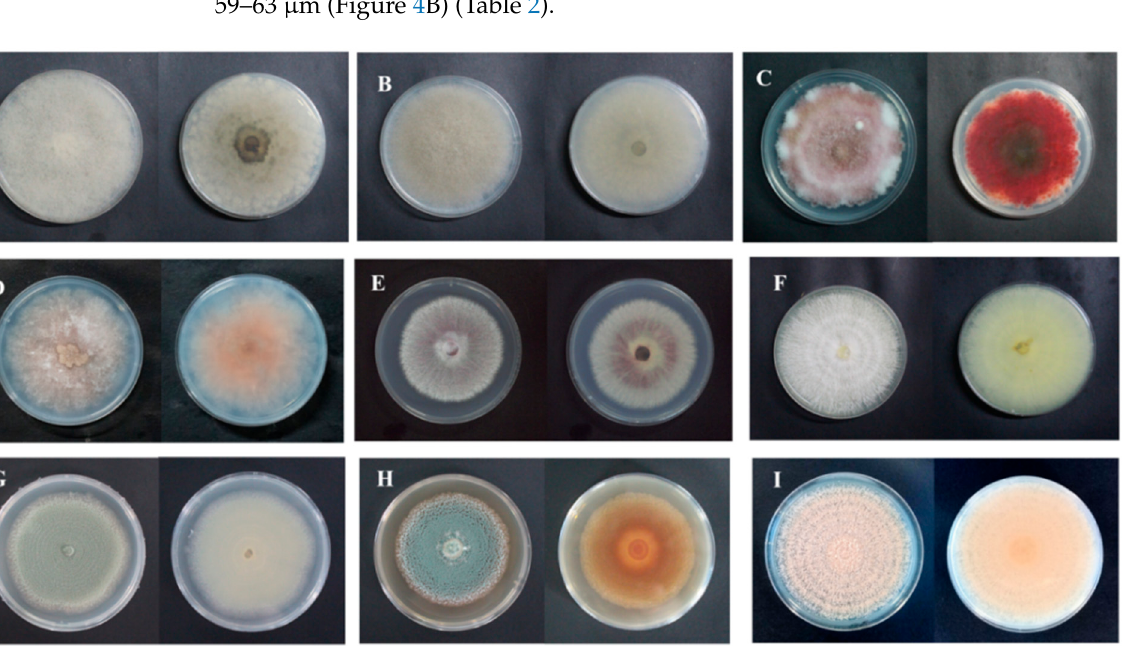
Figure 2. Colony morphology of isolates from fresh C. pilosula with postharvest disease during different storage stages. ( A ): Actinomucor elegans ; ( B ): Mucor hiemalis ; ( C ): Fusarium acuminatum ; ( D ): Fusarium equiseti ; ( E ): Fusarium oxysporum ; ( F ): Clonostachys rosea ; ( G ): Penicillium expansum ; ( H ): Penicillium aurantiogriseum ; ( I ): Trichothecium roseum .